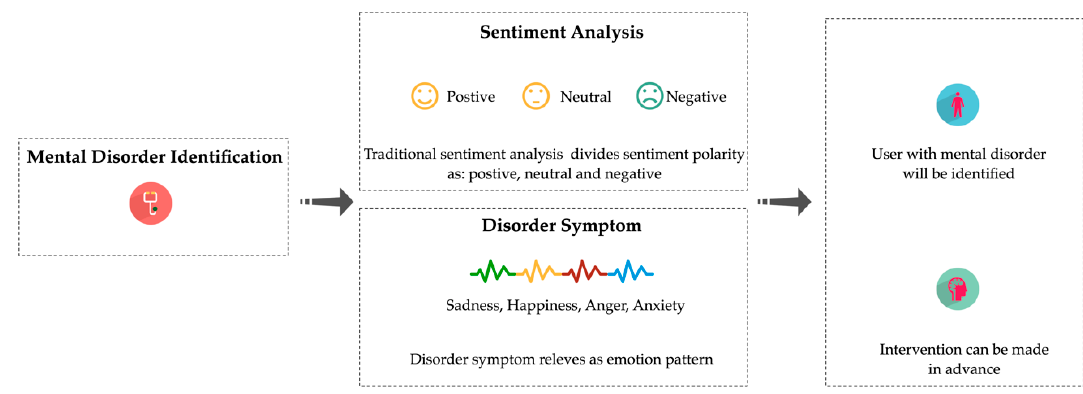
Figure 2. Application of sentiment analysis and sequential emotion.